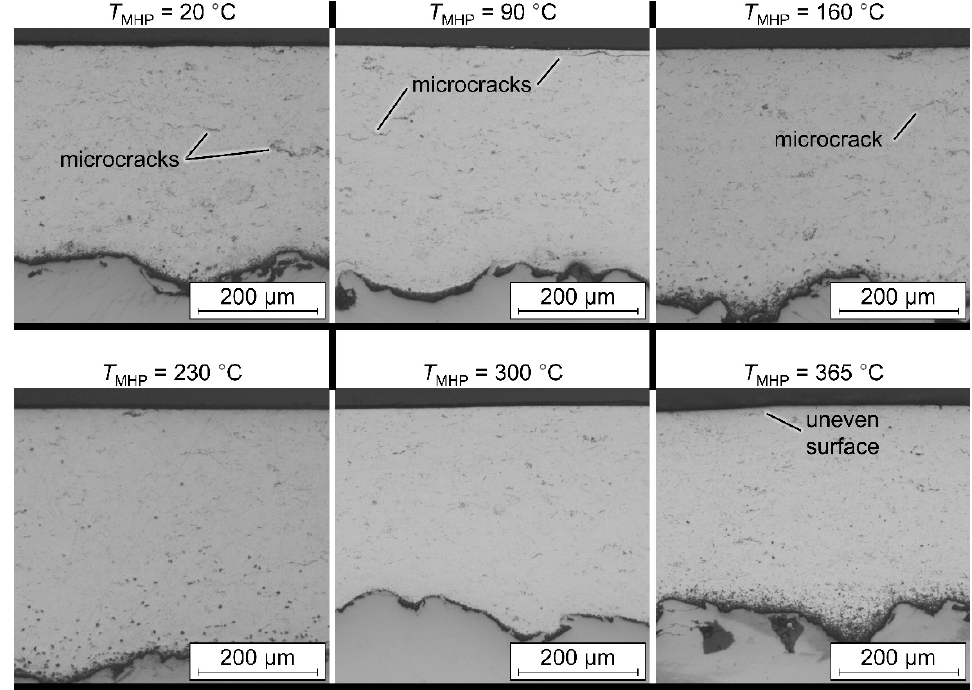
Figure 7. Light microscopic images of the TaMHP coatings peened at T MHP = 20–365 °C.